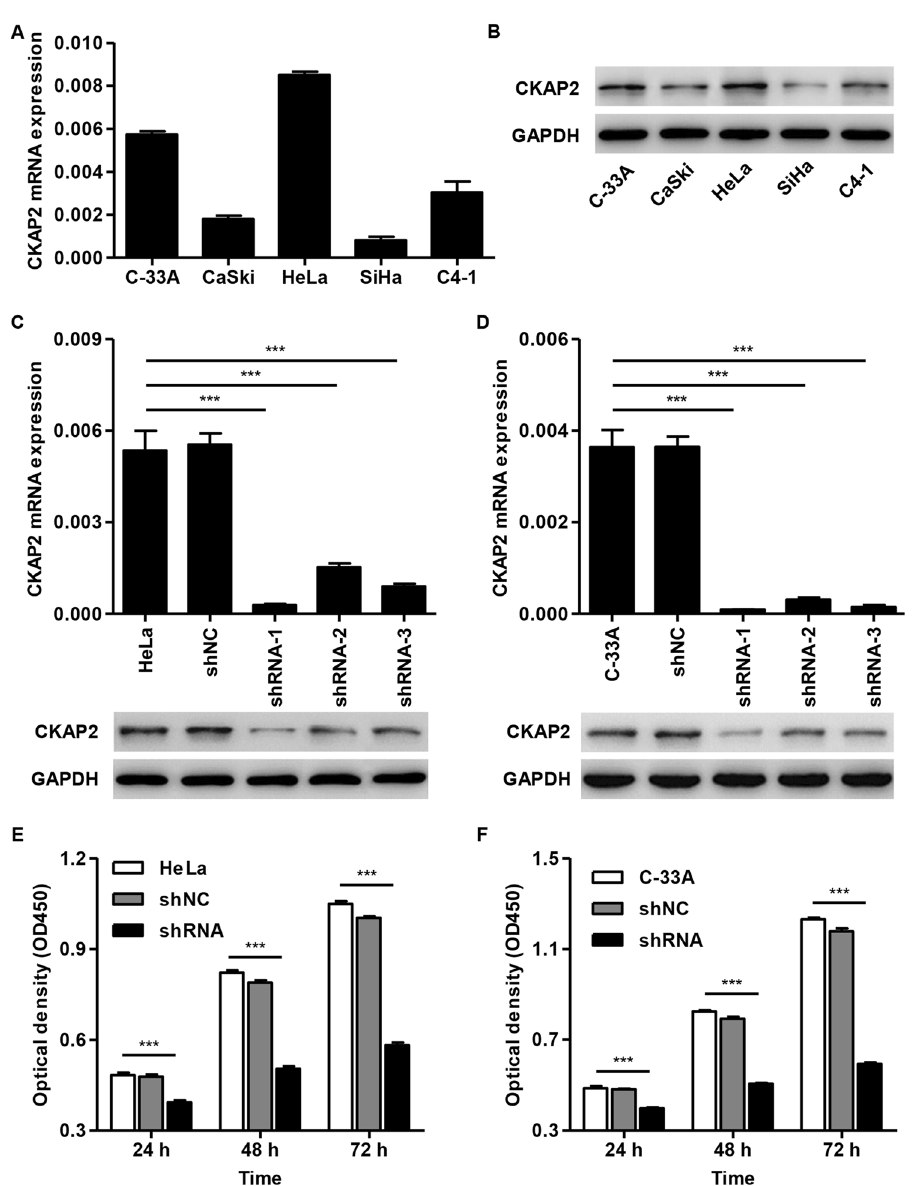
Figure 2. Effect of CKAP2 on cervical carcinoma cell proliferation. ( A , B ) The expression of CKAP2 in five human cervical carcinoma cell lines was assessed by Real-time PCR and Western blot. ( C , D ) Successful knockdown of CKAP2 in HeLa and C-33A cells was confirmed by Real-time PCR and Western blot at 48 h after infection with pLKO.1-EGFP-CKAP2 shRNA or pLKO.1-EGFP-shNC control lentivirus. ( E , F ) HeLa and C-33A cell proliferation was detected using CCK-8 assay at 24, 48, and 72 h. *** P <